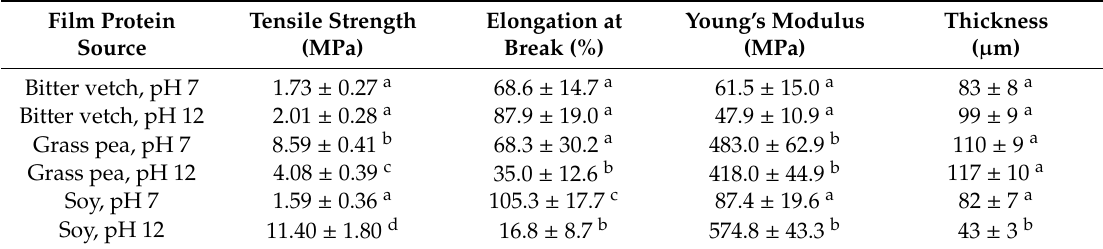
protein sources.